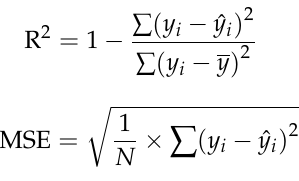
and trait, Table S2: Evaluation of models built with different machine learning algorithms, Table S3. Number of samples in each treatment, Figure S1: Variable importance in projection (VIP) scores in models predicting the relative water content with the responses of Tx623 and B35, Figure S2: Variable importance in projection (VIP) scores in models predicting the relative water content with the responses of Tx623 and